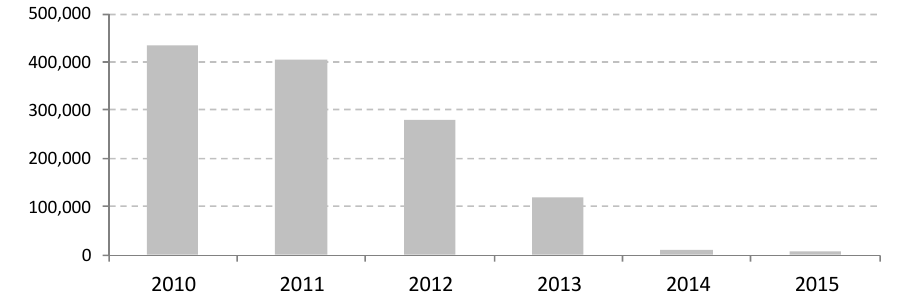
Figure 2. New PV potential installed in Spain (in kW) [44].